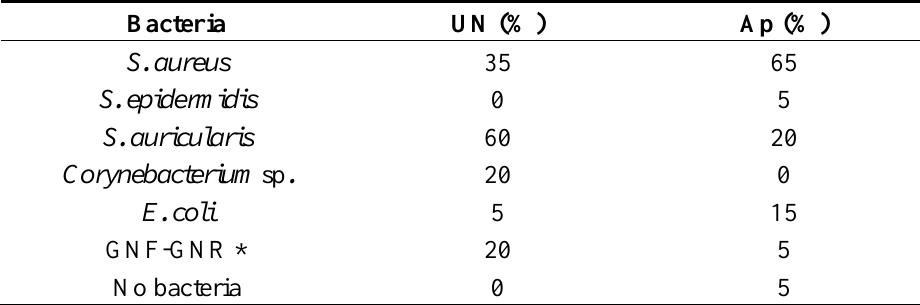
Table 1. Detection rates of bacteria in pin tracts for the UN and Ap